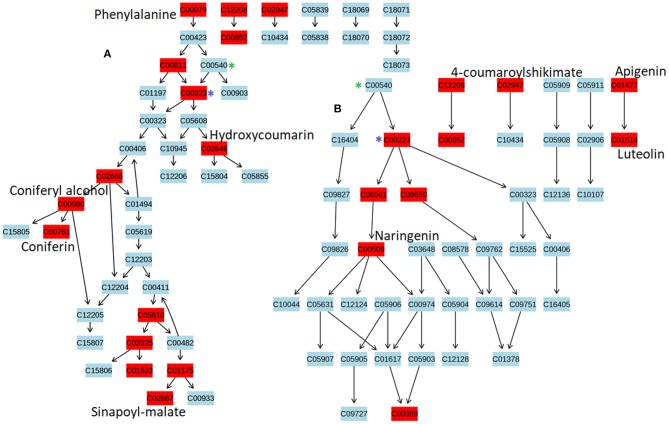
The topological characteristics of phenylpropanoid and flavonoid pathways. Graphs were generated from Metabolomics Pathway Analysis using MetPA. (A)
Phenylpropanoid pathway map displaying some of the OPLS-DA selected metabolites, altered in response to C. sublineolum infection. (B) Flavonoid pathway map showing OPLS-DA selected metabolites altered during sorghum responses to C. sublineolum infection. (*) indicate overlapping points where metabolic pathways interconnect. Due to the limitation of the MetPA tool (considering the database used and search algorithm) not all metabolites that were chemometrically extracted (Table 2) could be mapped in the constructed pathway graphs.